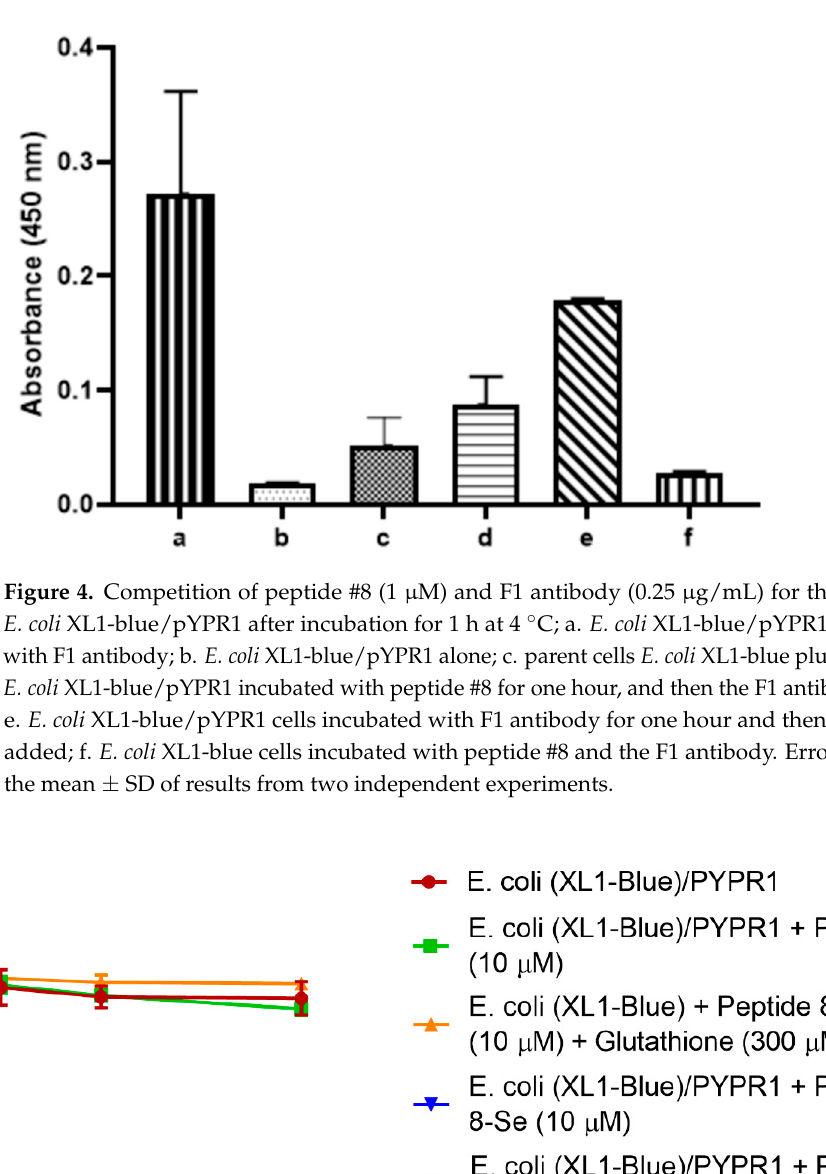
Figure 6. The effect of seleno-peptide #8 (10 µM) on the E. coli XL1-blue/pYPR1 strain, with or without glutathione, under added oxygen at 4 °C. Values represent the mean from three independent experiments. 3. Discussion The known virulence factors of Y. pestis are encoded on its chromosome and three plasmids [2,21–25]. The major virulence factors of Y. pestis are located in the outer mem- brane and enable the bacteria to directly translocate into host cells through a type 3 secre- tion system (T3SS) [2]. One of these virulence factors is the major capsular antigen fraction 1 (F1), which is essential for protecting the organism against phagocytosis [3,26]. This unique F1 antigen, which is coded by a 100-kb plasmid of Y. pestis , is antiphagocytic and essential for full virulence in some animal species [25,27,28]. In addition, Y. pestis exhibits